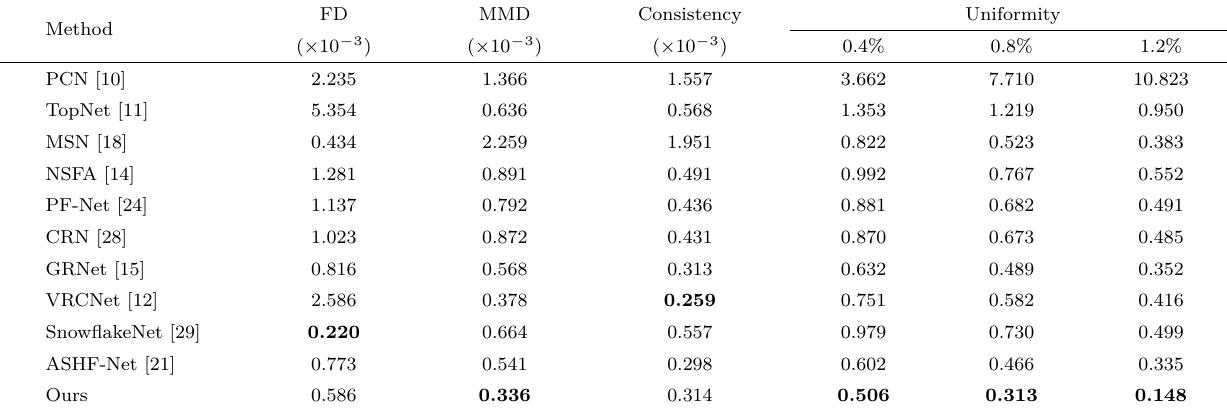
Table 3 Shape completion results on the KITTI dataset: fidelity distance (FD), minimal matching distance (MMD), consistency, and